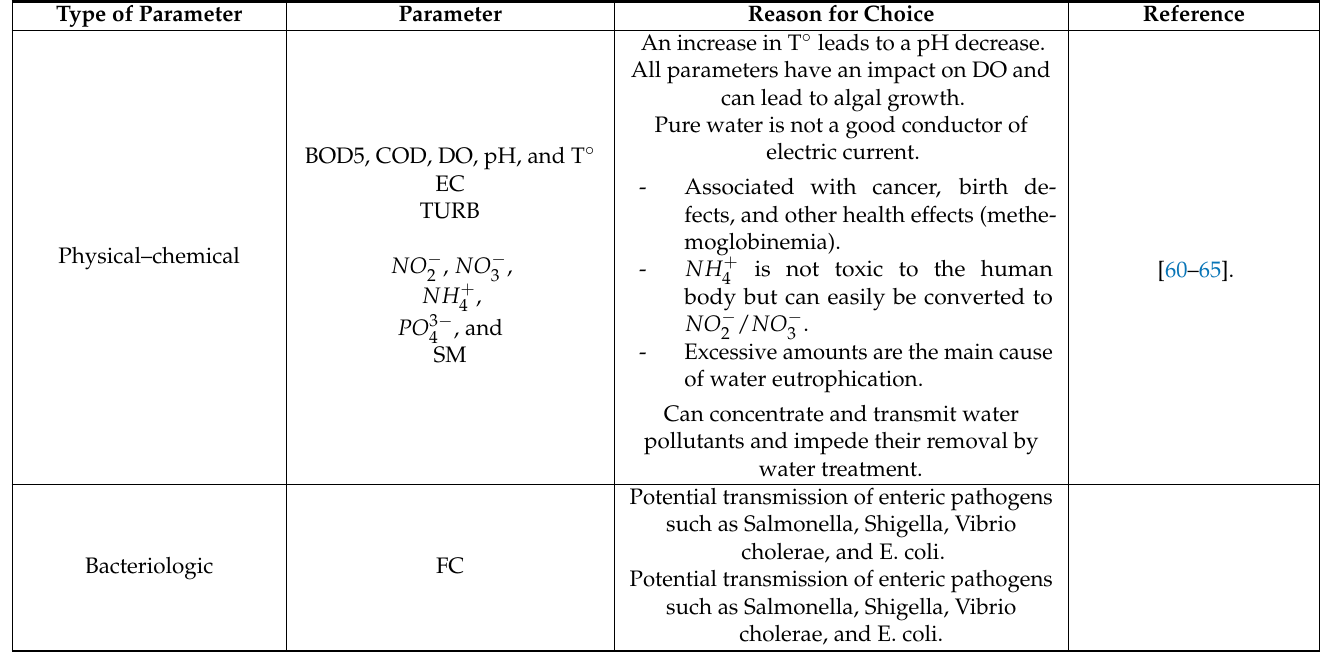
Table 1. The analyzed parameters during this study and the reasons for the parameters’ selection with references.